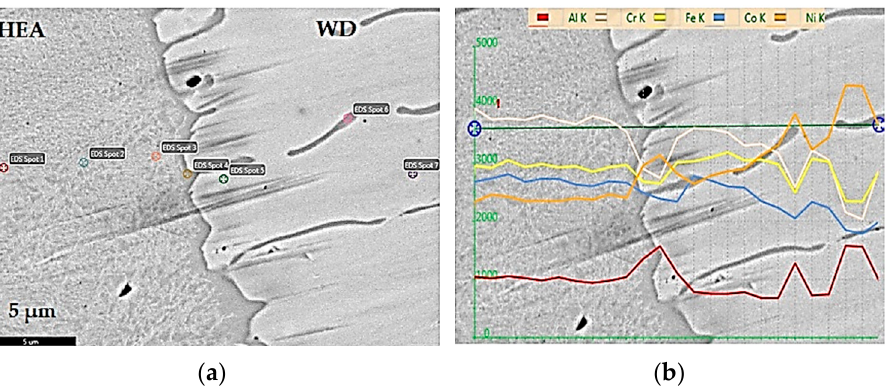
Figure 5. Distribution of the main chemical elements through the fusion line between HEA and weld metals: ( a ) HAZ—Spot 1 to 3; FL—Spot 4; WD—Spot 5 to 7; ( b ) chemical elements modification on the cross direction on the fusion line.